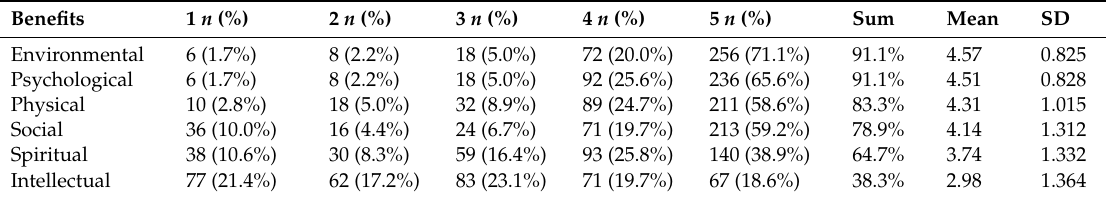
Table 4. Rating of perceived health and well-being benefits derived from visiting the PNA. Descriptive statistics and tests of significance (N = 360).